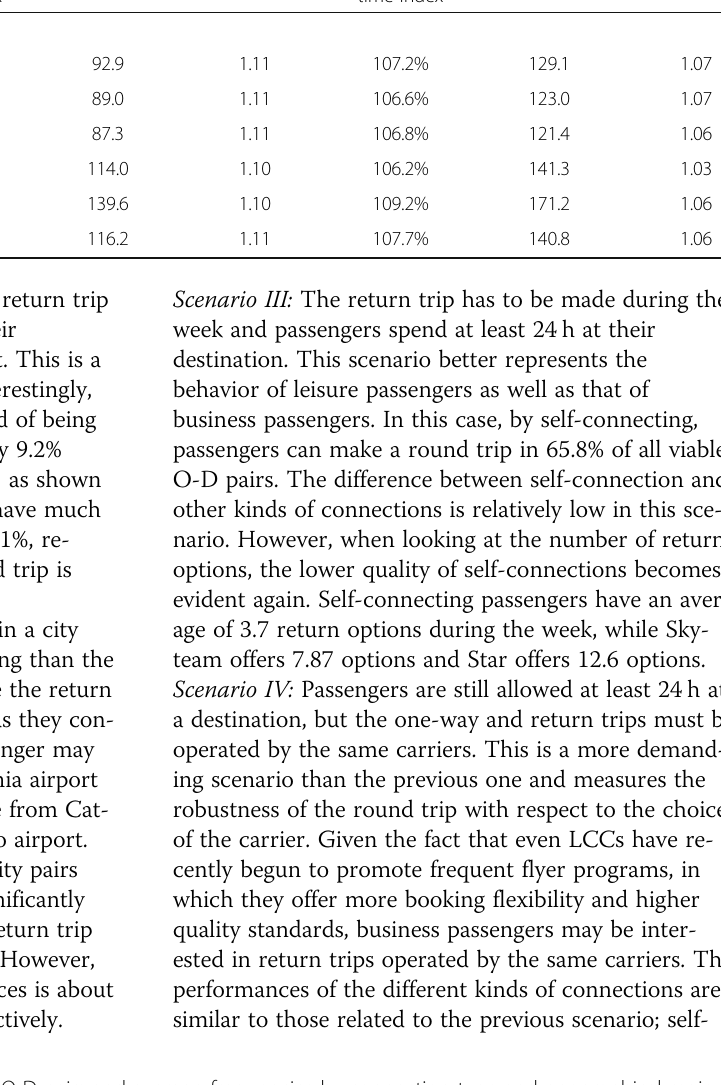
Table 4 Number of viable connections, number of O-D pairs and average frequencies by connection type and geographical regions